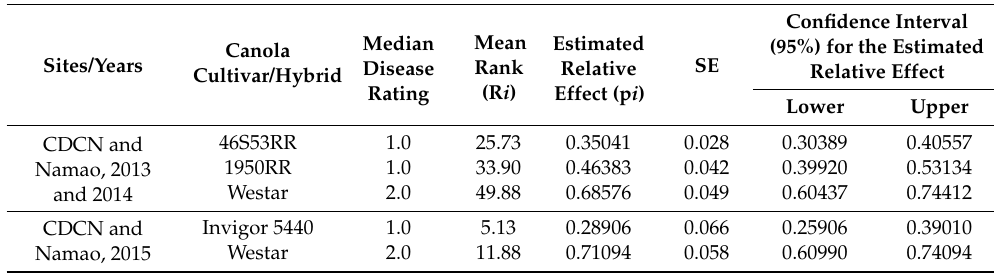
Table 1. Median rank and estimated relative effects (p i ) of the canola hybrids “46S53RR”, “1950RR”, “Invigor 5440”, and the cultivar “Westar” on blackleg severity. Trials were conducted under field conditions near Edmonton (Crop Diversification Centre North; CDCN) and Namao, Alberta in 2013, 2014 and